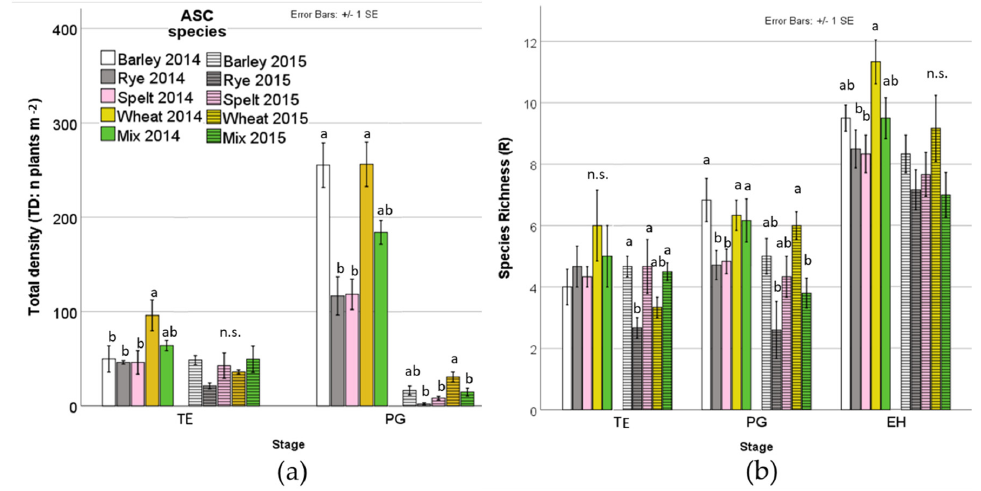
Figure 3. Weed total density ( a ) and species richness ( b ) as affected by ASC species over the two years experiment. ASC: agroecological service crop; TE: termination; PG: plant growth; EH: end of harvest. Different Roman letters indicate significant different weight according to lsmeans and Tukey post-hoc tests; n.s.: not significant.